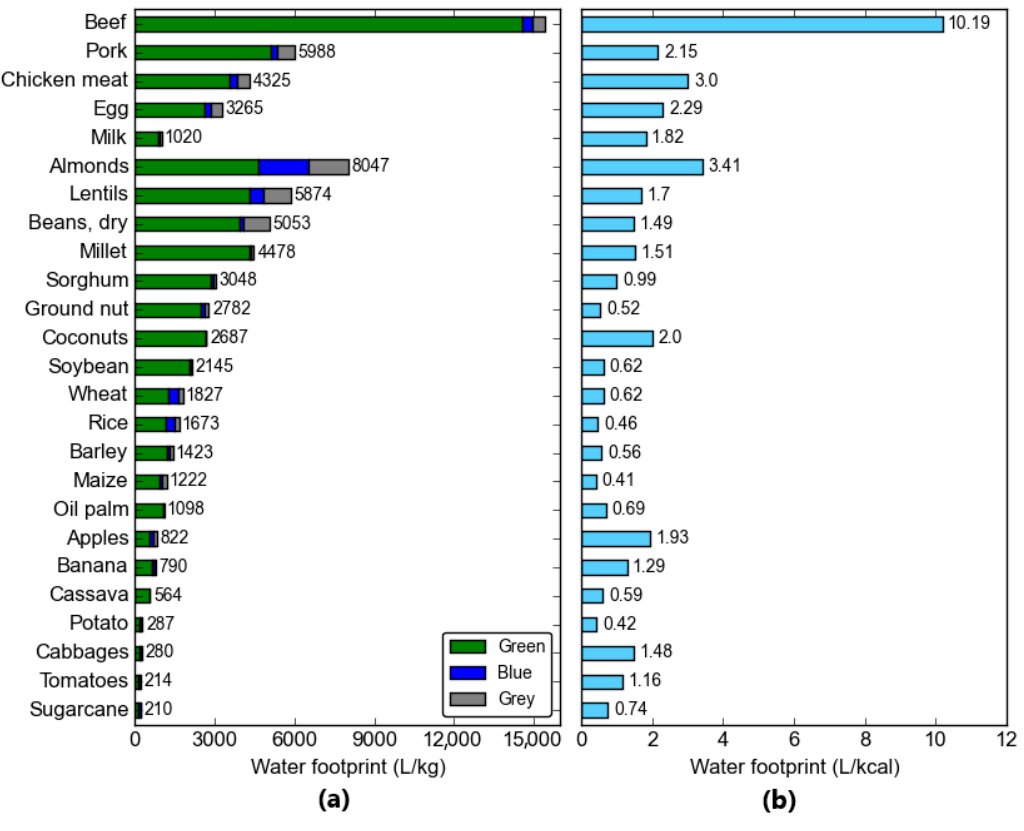
Figure 2. The WF of selected crop and animal products: ( a ) WF in a liter of water per kg of product, ( b ) WF in a liter of water per kcal of nutritional energy contained in the product. Data source from Mekonnen and Hoekstra [29] and Mekonnen and Hoekstra [37].